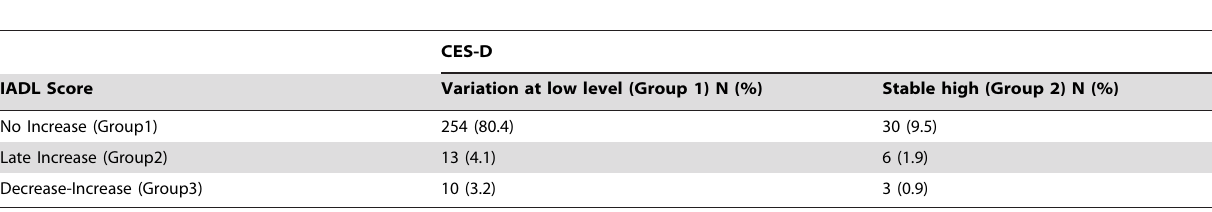
Table 3. Joint trajectory group membership probability of IADL score and CES-D score